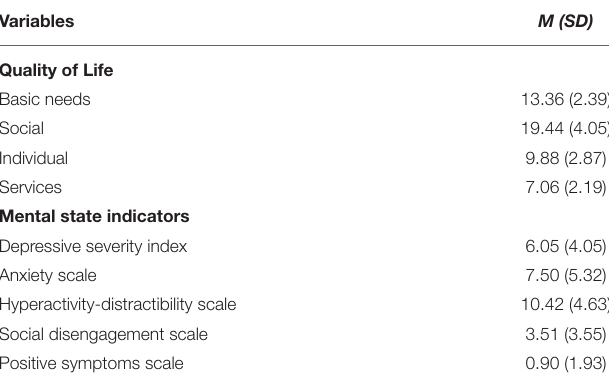
TABLE 2 | Summary of mean scores for dependent and predictor